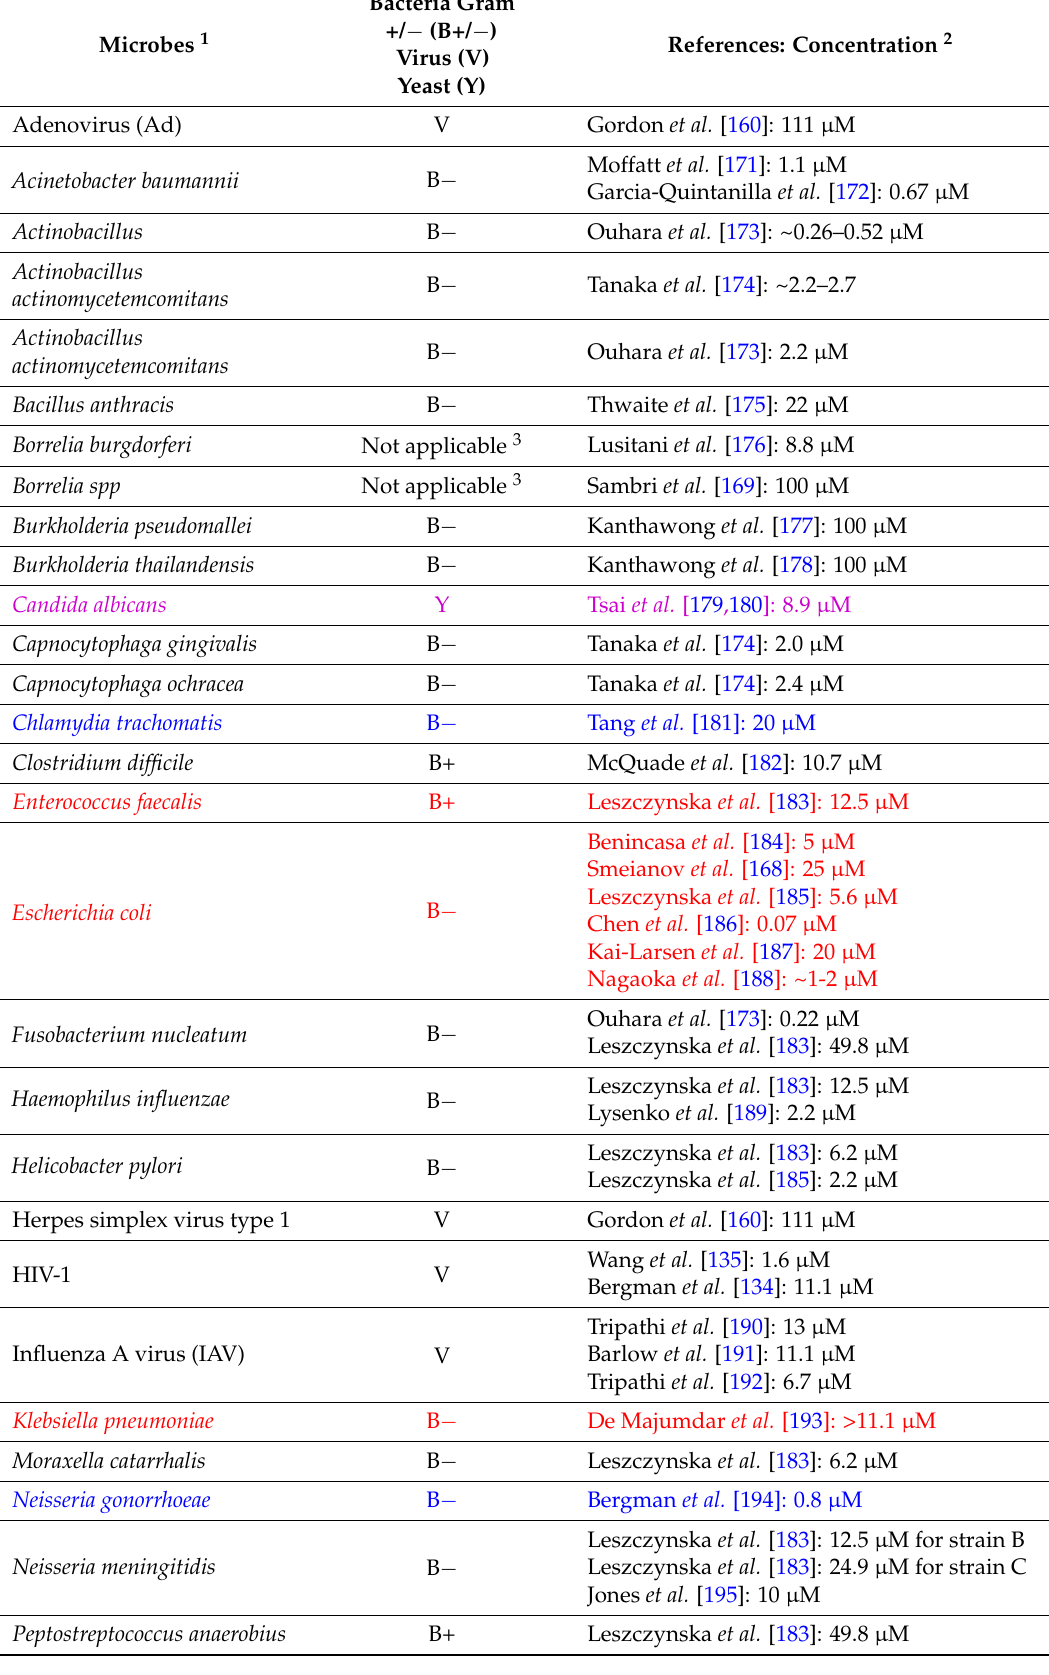
Table 4. Microbicidal effects of